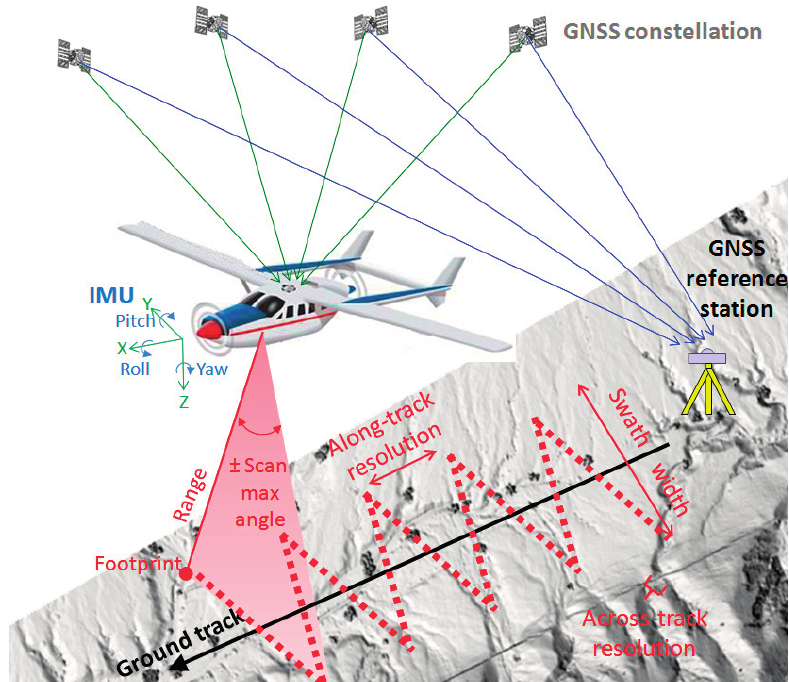
Figure 2. Schematic diagram illustrating the basic operational principles and main system components of ALS